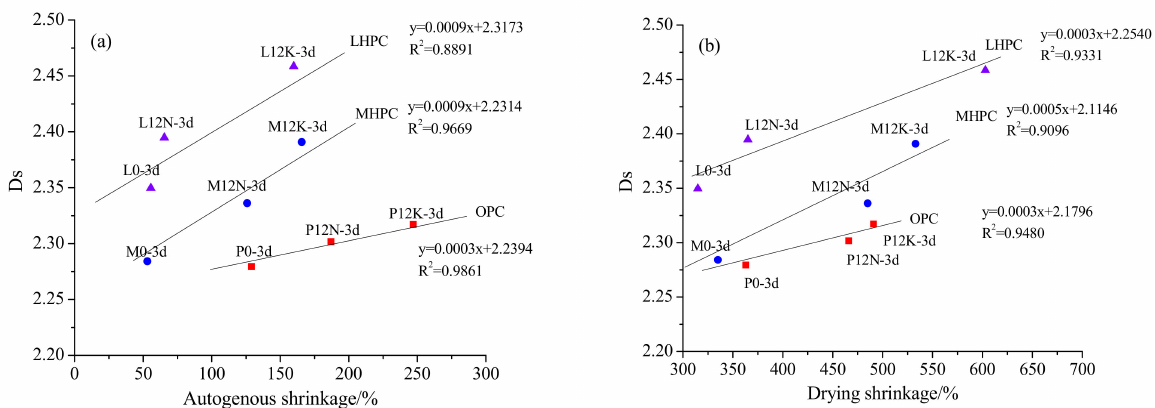
Figure 13. Relationship between shrinkage behavior and D s of mortars with different alkali sulfates contents. ( a ) Autogenous shrinkage; ( b ) drying shrinkage.